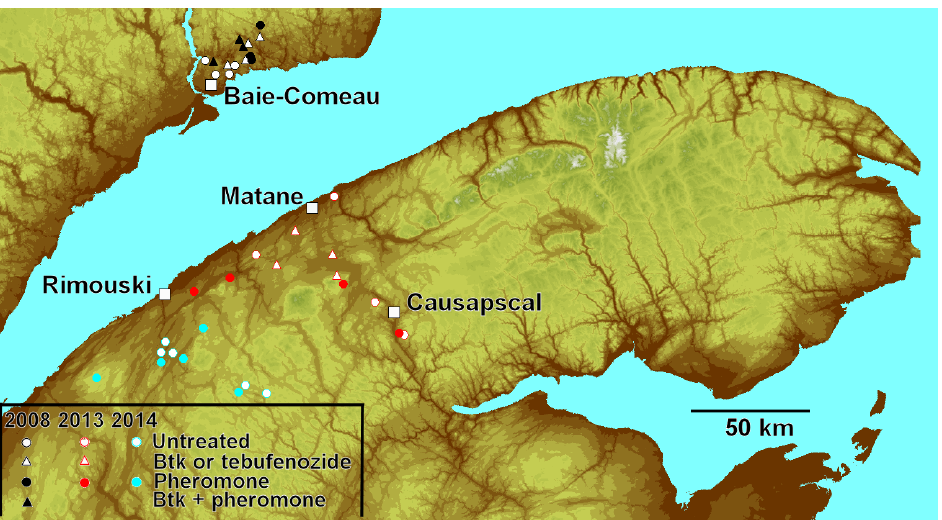
Figure 1. Elevation map of the eastern portion of southern Quebec, Canada (the Gaspé peninsula), showing the location of all plots in this study. Black: 2008. Red: 2013; Blue: 2014. Open squares: Selected city locations.